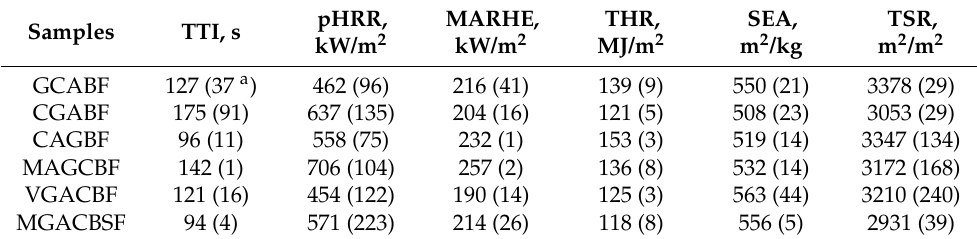
Table 3. Cone calorimeter results of